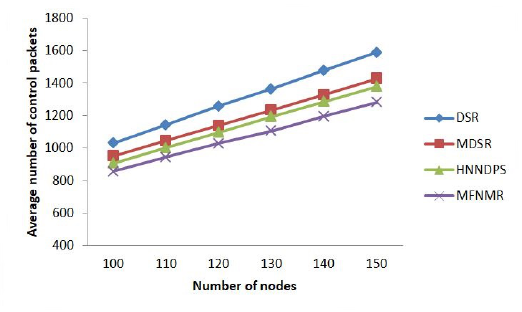
Figure 5. Routing Overhead Analysis based on Number of Nodes.